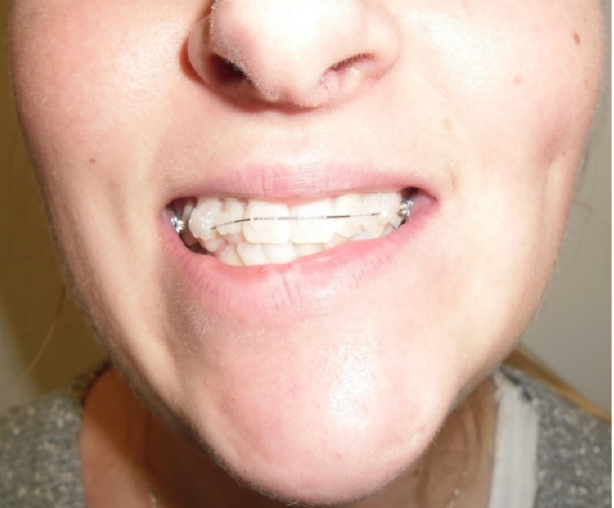
Figure 2. Visible lack of balance in lip contour with deviated maxillary bite plane and open bite present on the affected right side. The degree of maxillary deviation is related to the degree and volume of abnormal growth in the affected condyle over time. Open bite suggests an increased volume of pathological growth and low compensatory maxillary downward rotation. In the following cases, orthodontic treatment has its limitations, even after a